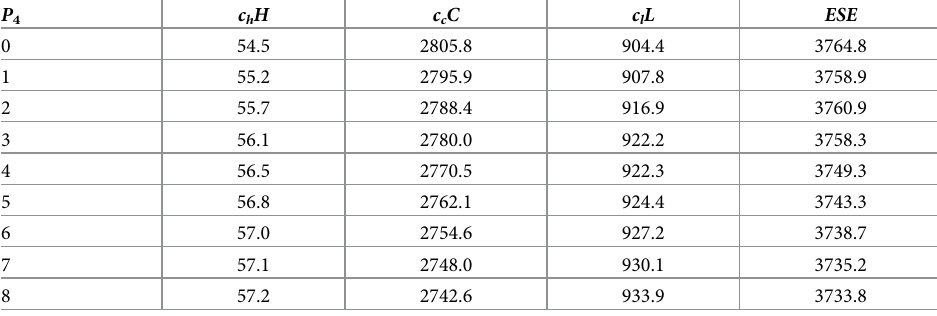
Table 5. Heating, cooling and lighting loads for cellular office model in Miami when the position of control point P 4 is varied in the optimal shading.